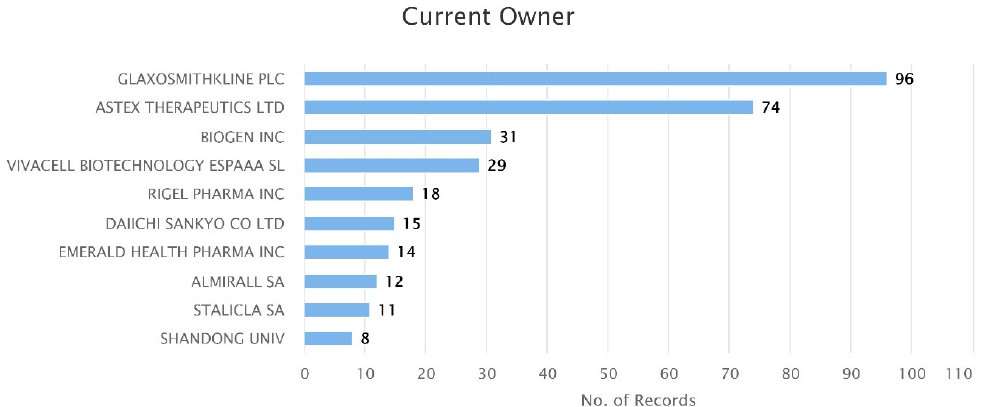
Figure 2. The top 10 owners of nuclear factor erythroid 2-related factor 2 (Nrf2) patents published